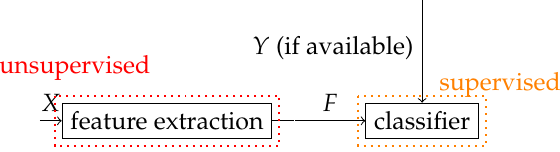
Figure 1. Semi-supervised learning. Feature extraction is performed in an unsupervised fashion, while classification is based on a supervised approach